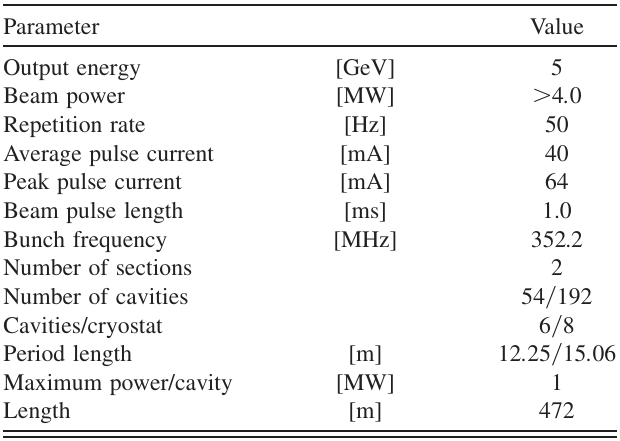
TABLE I. SPL parameters used in this